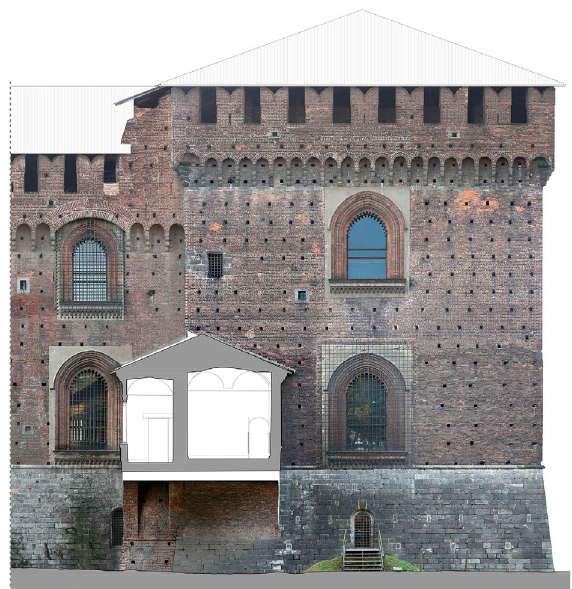
Figure 5. Orthorectified image of the east